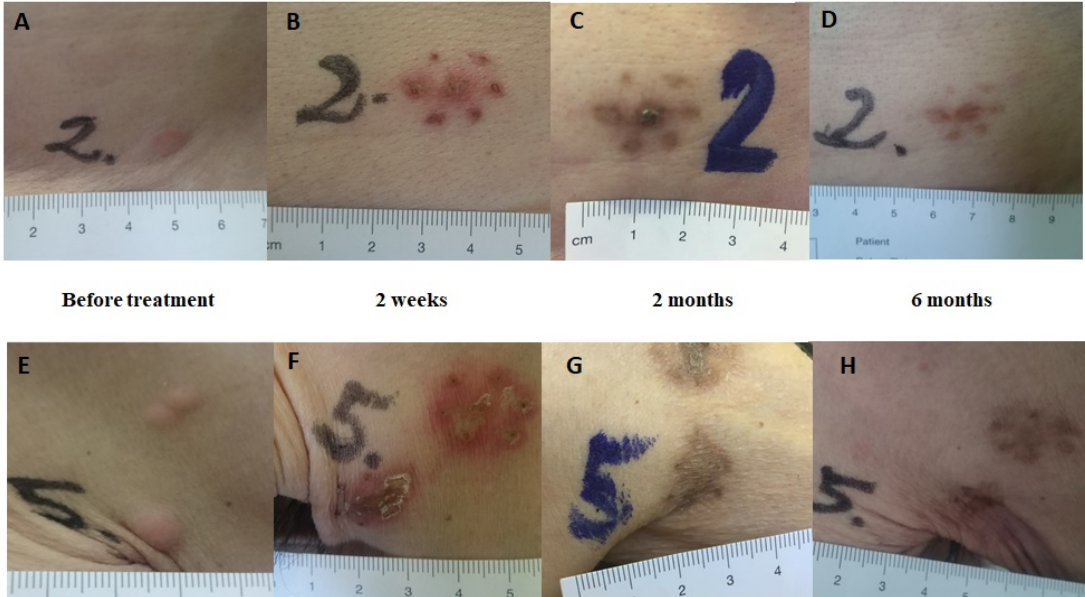
Figure 5. Clinical response. Clinical response after Ca-EP; clinical response after bleomycin-based ECT. The lesions are from patient no.2 with cutaneous metastases from breast cancer in the